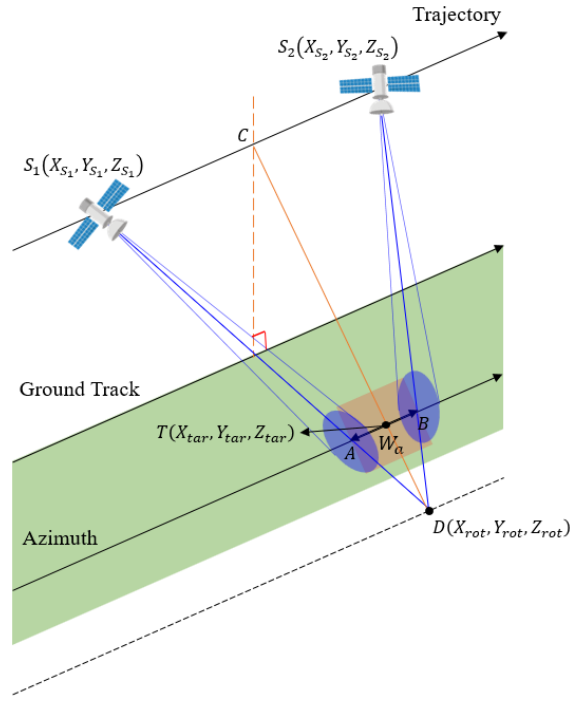
Figure 10. Steering target when satellite points toward the rotation